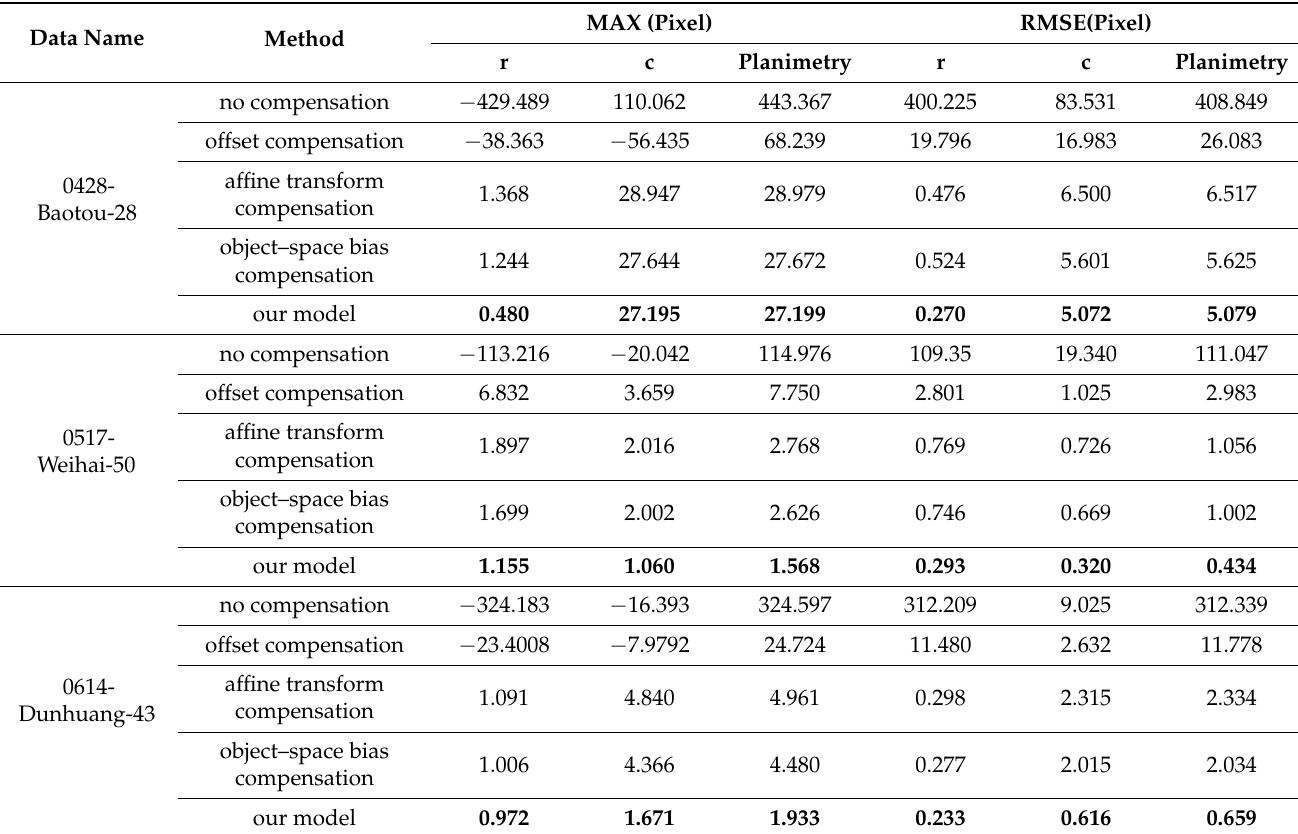
Table 4. Accuracy verification of different methods (The bold indicates the result with the best accuracy